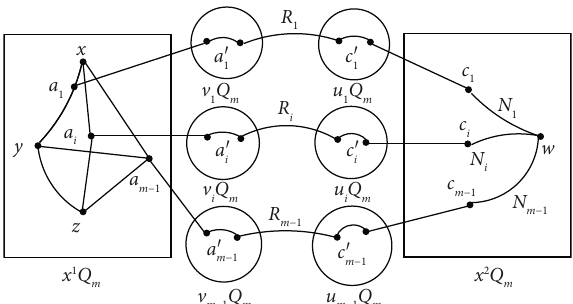
Figure 12: Te illustration of subcase 2.1 of Teorem 2.